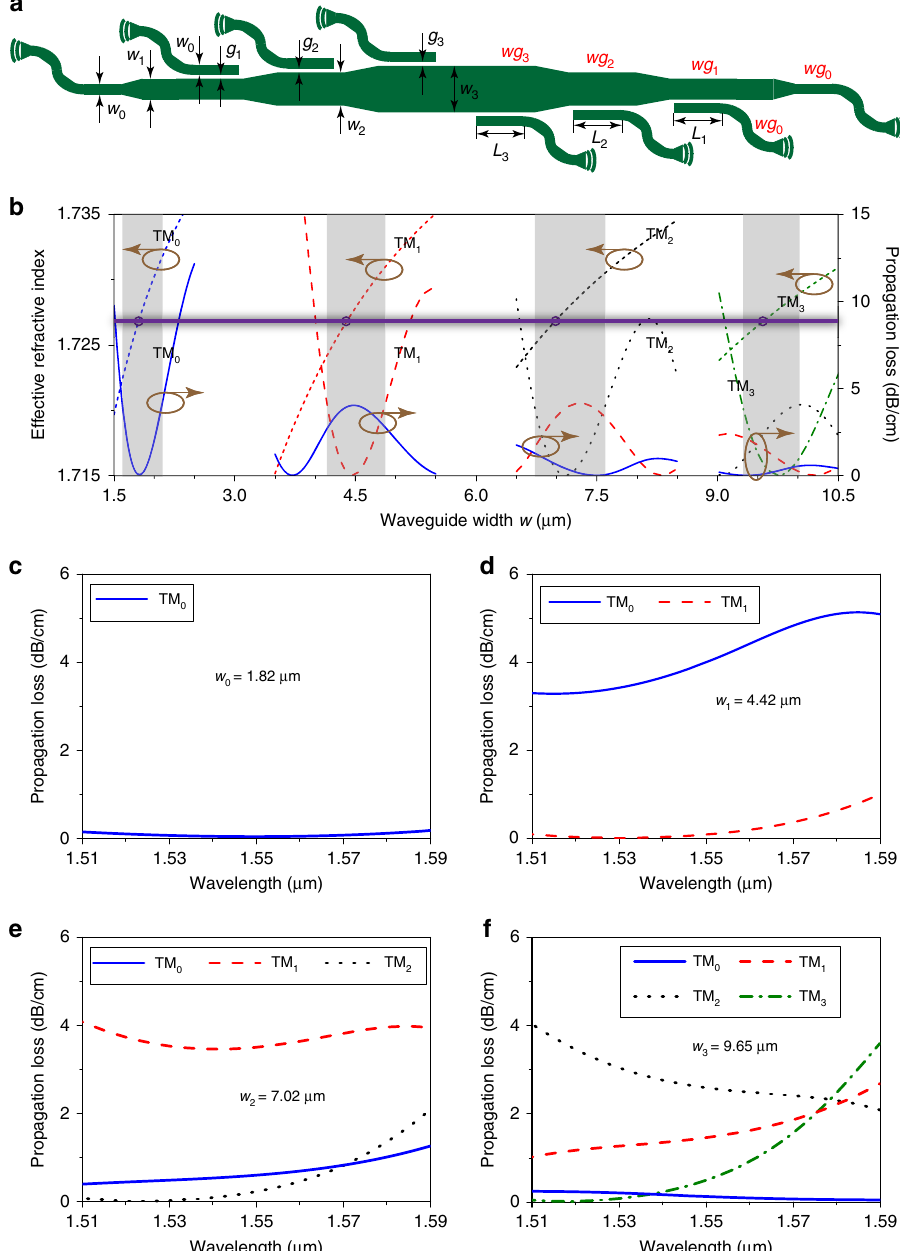
Fig. 2 Designing mode (de)multiplexer with BICs. a Illustration of a BIC-based mode (de)multiplexer. w 0 , w 1 , w 2 , and w 3 are the widths of waveguides wg 0 , wg 1 , wg 2 , and wg 3 , respectively. L 1 , L 2 , and L 3 are the lengths of coupling the TM 0 mode from waveguide wg 0 to excite the TM 1 mode in waveguide wg 1 , the TM 2 mode in waveguide wg 2 , and the TM 3 mode in waveguide wg 3 , respectively. g 1 , g 2 , and g 3 are the gaps between waveguide wg 0 and waveguides wg 1 wg 2 , and wg 3 , respectively. b Effective refractive index (short-dashed lines) and propagation loss of the TM 0 (solid lines), TM 1 (dashed lines), TM 2 (dotted lines), and TM 3 (dash-dotted line) modes as a function of the waveguide width w . The four circles on the purple solid line mark the chosen waveguide widths for simultaneous satisfaction of the phase-matching condition and low-loss propagation, which are w 0 = 1.82, w 1 = 4.42, w 2 = 7.02, and w 3 = 9.65 μ m. c – f Propagation loss spectra of the TM BIC modes in waveguides wg 0 , wg 1 , wg 2 , and wg 3 with the respective waveguide width w 0 = 1.82 μ m ( c ), w 1 = 4.42 μ m ( d ), w 2 = 7.02 μ m ( e ), and w 3 = 9.65 μ m ( f